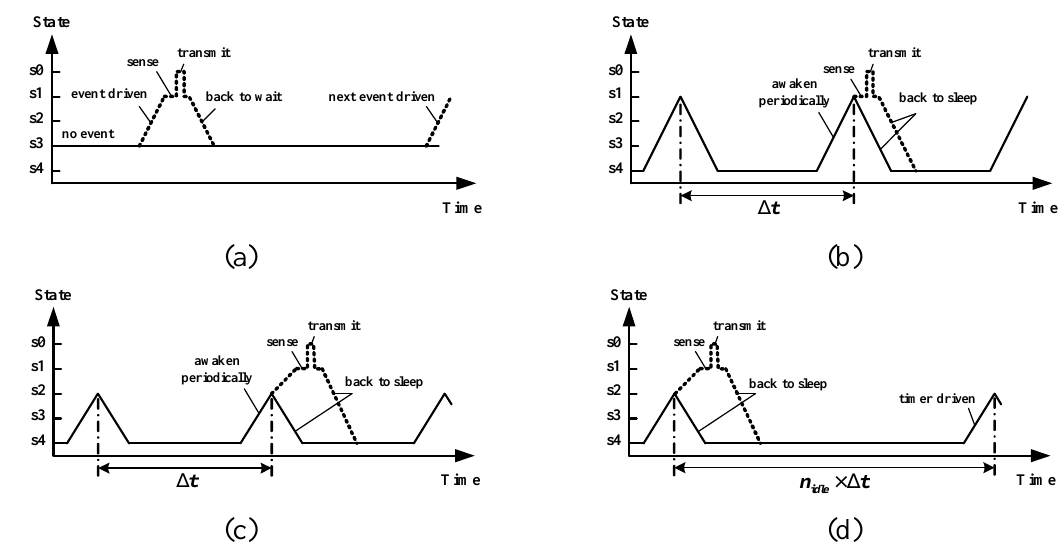
; (d) Prediction-based dynamic 2